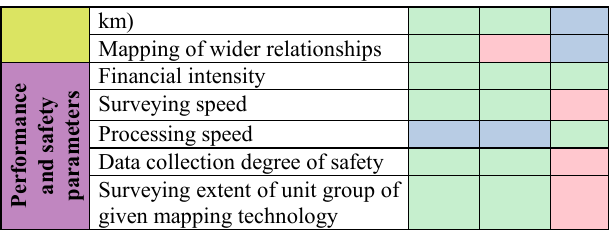
Table 3. The major findings and